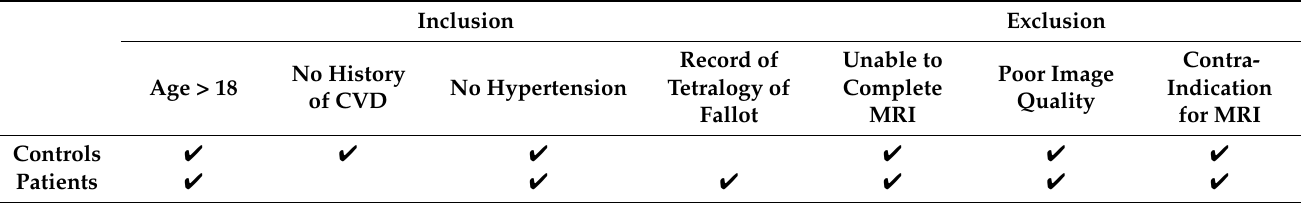
Table 1. Acquisition parameters for